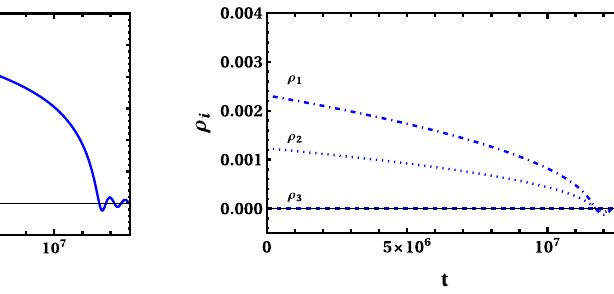
Fig. 2 The time evolution of each background field ¯ φ I in M P units for the BP a . The solid line in left panel correspond to the evolution of ϕ field while dot-dashed, dotted and dashed lines in right panels corre- spond to the evolution for ρ 1 , ρ 2 and ρ 3 fields respectively. To find the